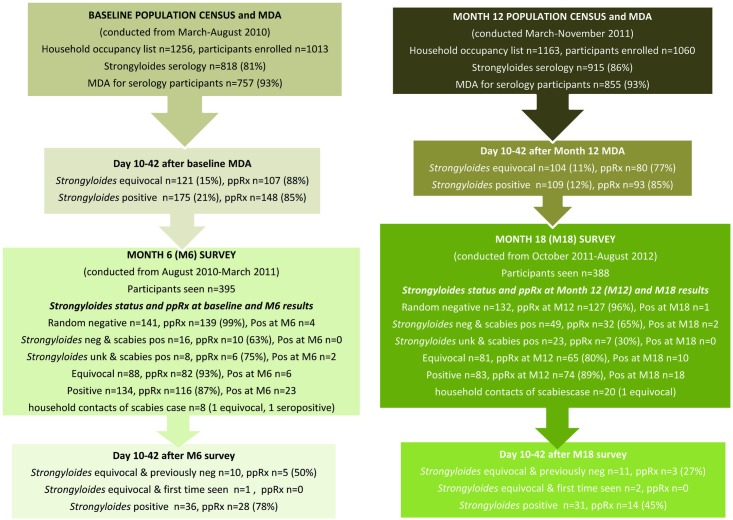
Flowchart of study design and results.